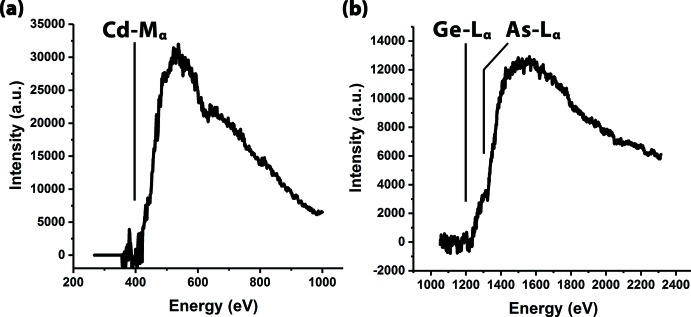
EELS spectra showing the identification of (a) Cd-M
α, (b) Ge-L
α, and (b) As-L
α energy lines that were used for elemental identification and mapping.